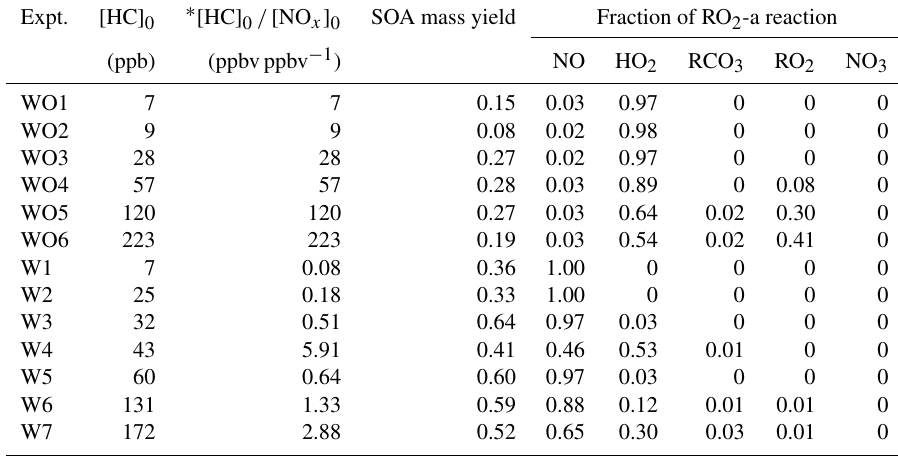
Table 6. Fractions of peroxy radical RO 2 -a reactions of each type, calculated based on SAPRC simulations. Expt. [HC] 0 ∗ [HC] 0 / [NO x ] 0 SOA mass yield Fraction of RO 2 -a